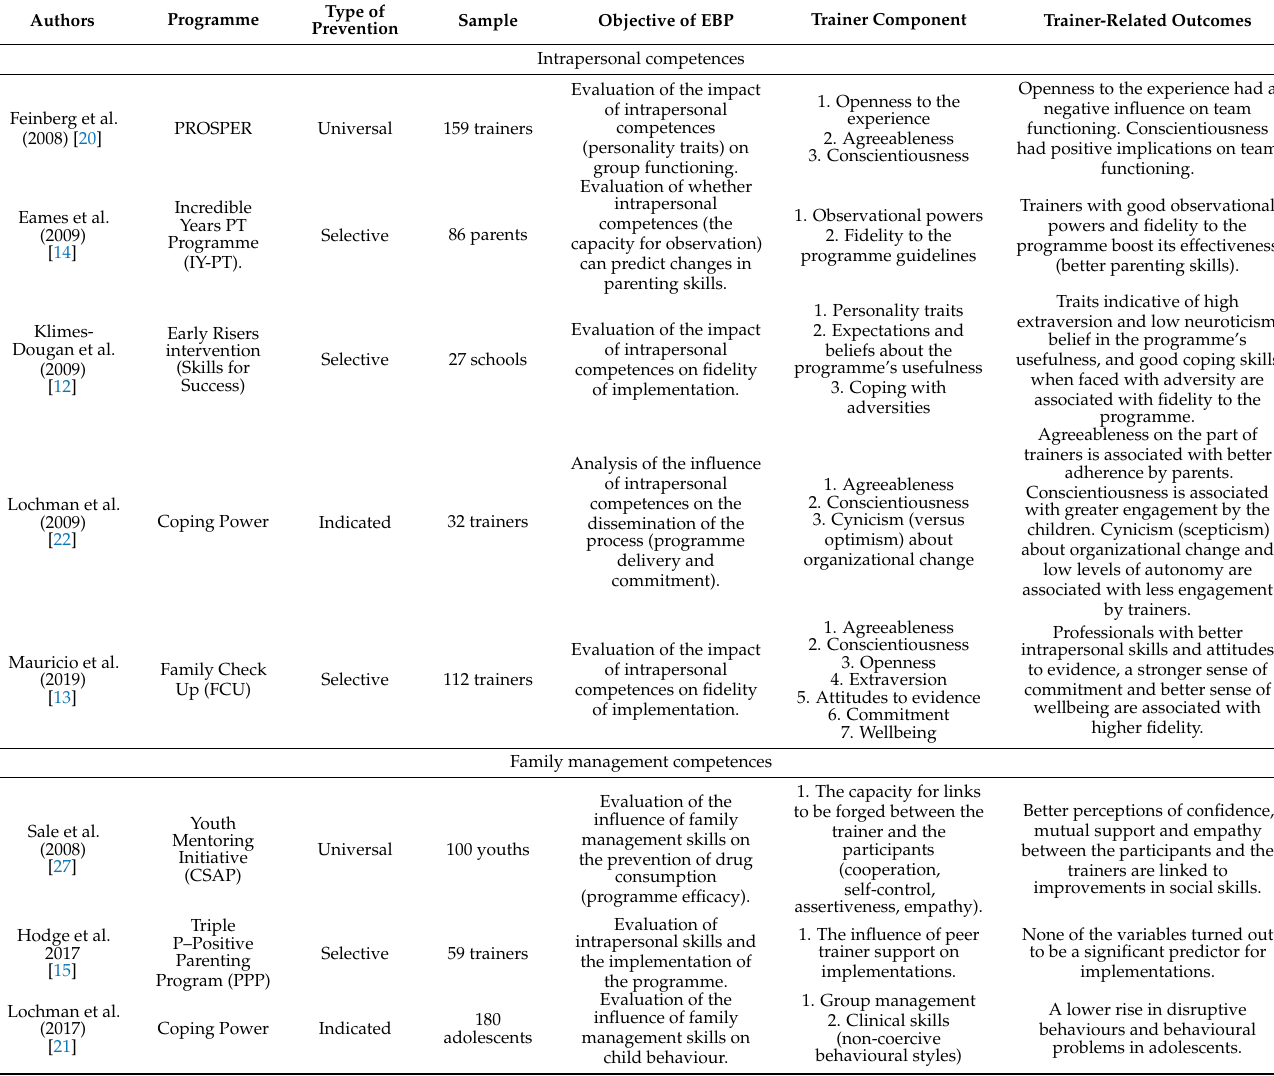
Table 1. Description of studies of evidence-based prevention programmes (EBP) for youths where the influence of the trainer is